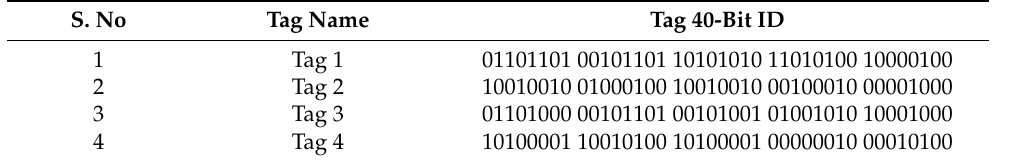
Table 2. List of Tags and their ID’s.